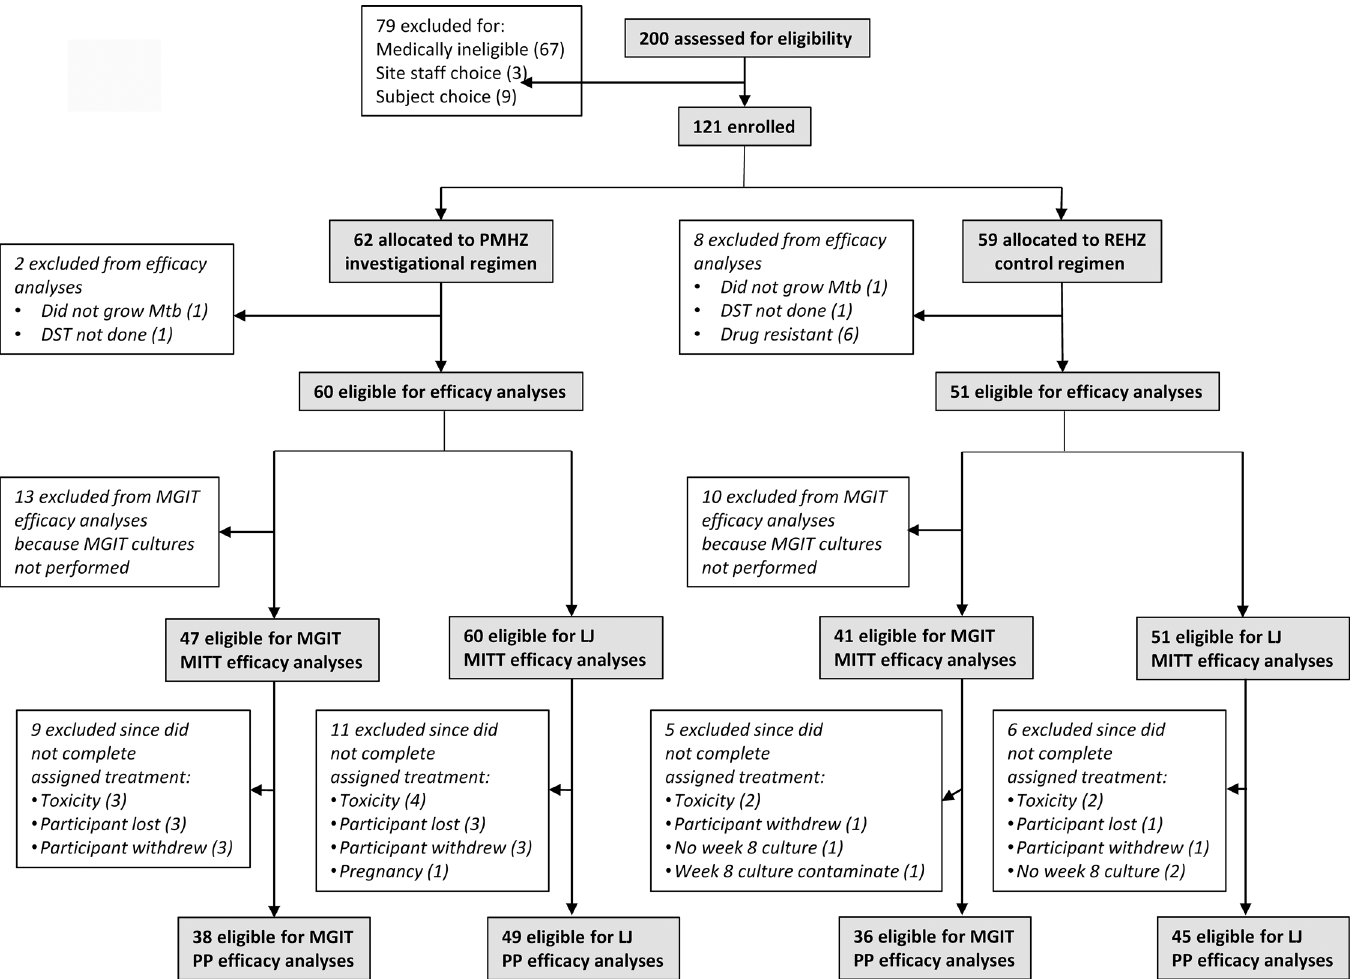
Fig 1. Enrollment and disposition of study participants. Abbreviations: PMHZ, investigational regimen comprised of rifapentine/moxifloxacin/isoniazid/ pyrazinamide; REHZ, control regimen comprised of rifampin/ethambutol/isoniazid/pyrazinamide; LJ, Löwenstein-Jensen culture; MGIT, Mycobacterial Growth Indicator Tube culture; MITT, modified intention-to-treat analysis population; PP, per-protocol analysis population; DST, drug susceptibility testing; Mtb, Mycobacterium tuberculosis .